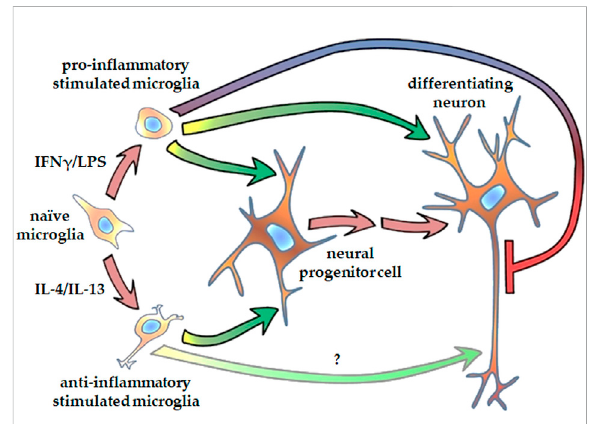
FIGURE 7 Schematic representation of how microglia affect neurite generation of human NPCs and differentiating neurons. Microglia stimulated either with proin fl ammatory agents, such as IFN γ and LPS, or with anti-in fl ammatory cytokines, such as IL-4 and Il- 13, promote neurite outgrowth in human neural progenitor cells. Proin fl ammatory activated microglia augment dendritic development, but inhibits axon generation in differentiating hippocampal DG granule cells. Microglia stimulated with anti- in fl ammatory cytokines supposedly support axon generation in granule